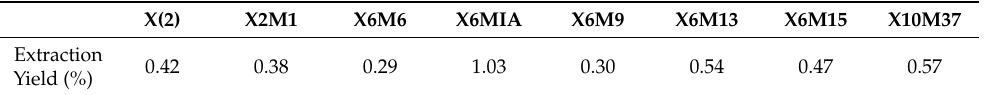
Table 1. Yield of EOs of the eight studied L. alba genotypes.